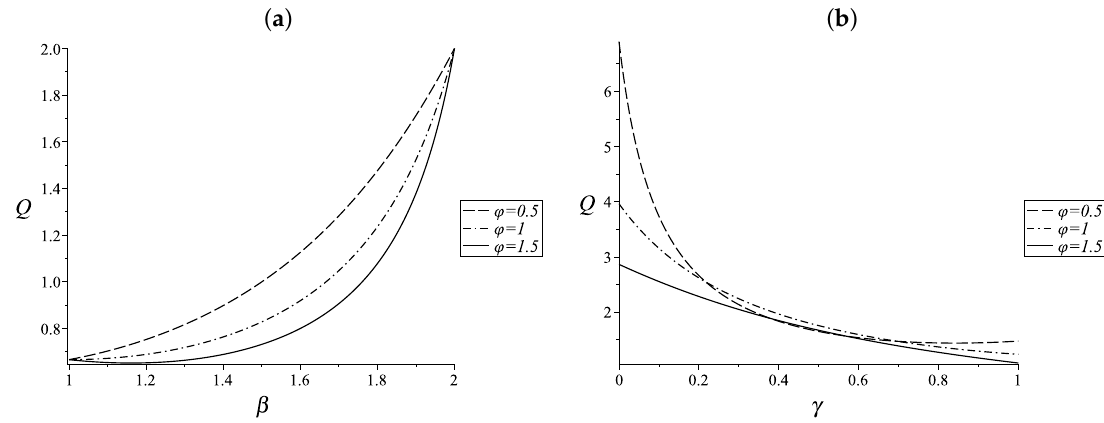
Figure 6. Calculated Q-factor curves plotted depending on the values of the parameters β ( a ) and γ ( b ).